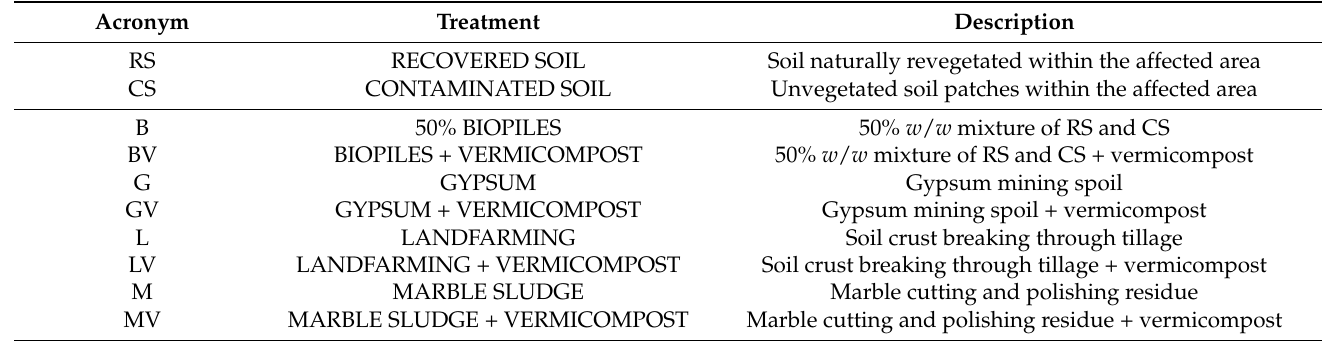
Table 1. Description of the treatments used for soil remediation and the corresponding descrip- tor